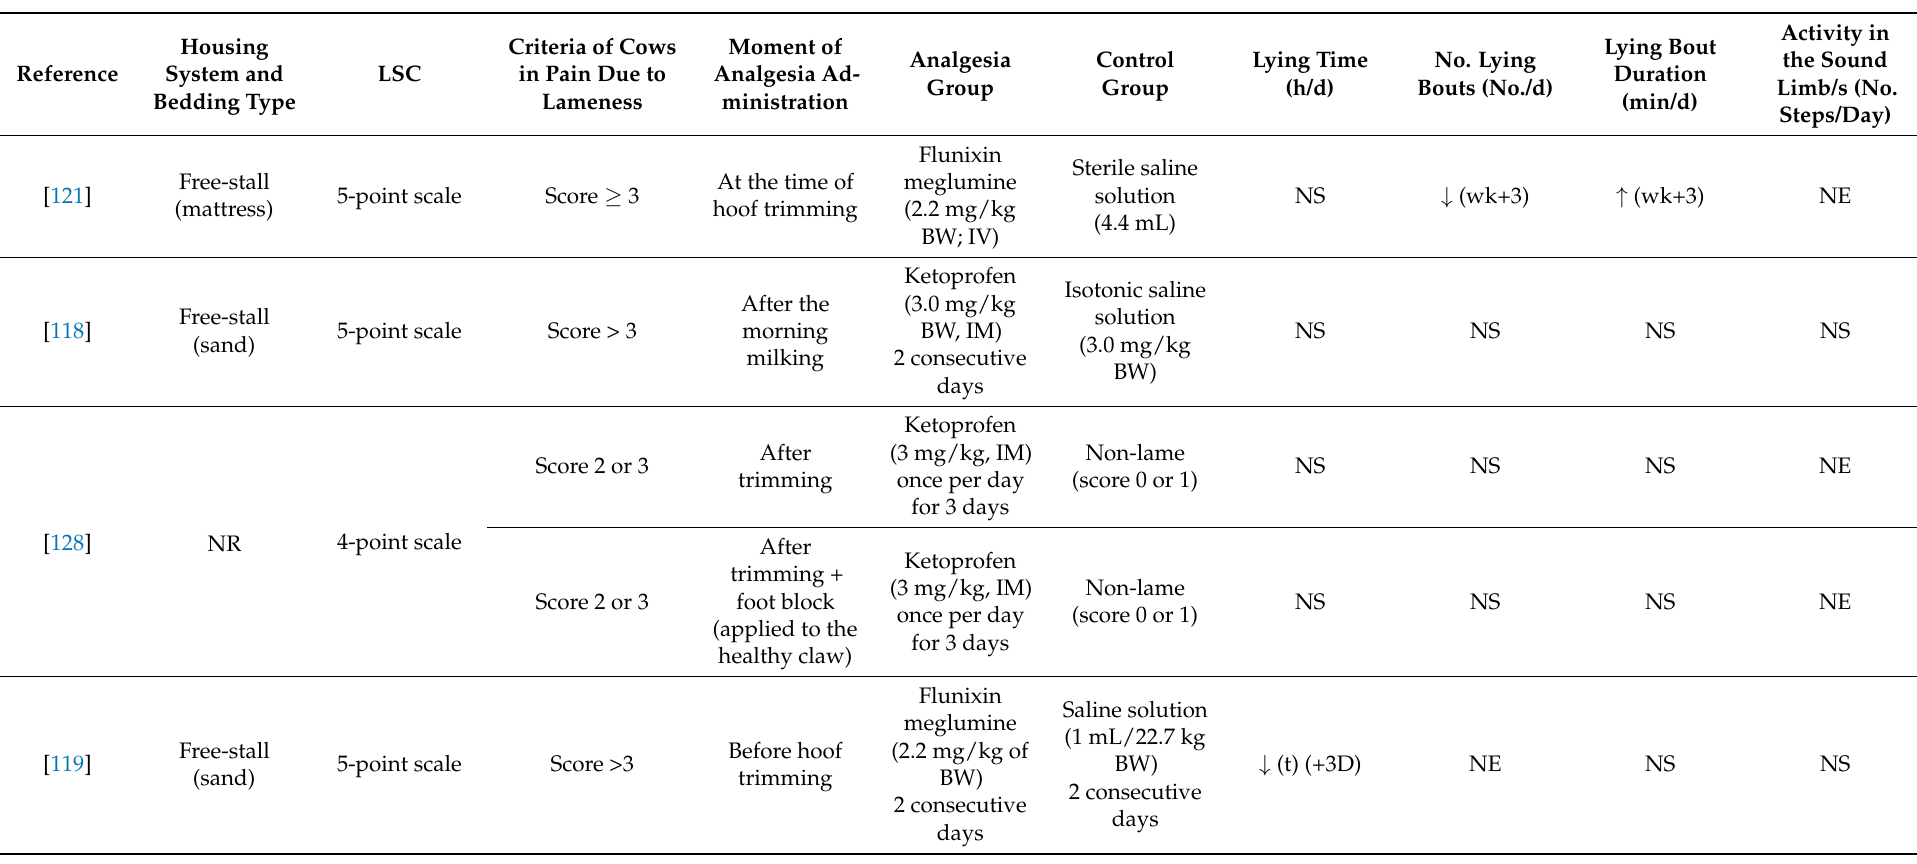
Table 3. Summary of changes in activity patterns in cows (lying time, number of lying bouts, lying bout duration, and activity in the sound limb/s) caused by lameness, observing cows with and without analgesia (analgesia vs. control group). Lameness assessment score (from 1 = non-lame to 3 or 5 = severely lame), housing system and bedding type and the moment of analgesia administration are documented. Moment (in days, d, or weeks, wk, related to moment of analgesia administration) and type of change ( ↑ increase; ↓ decrease; NS = non-significant; NE = non-evaluated; NR = non-reported) are given comparing the analgesia group with control group